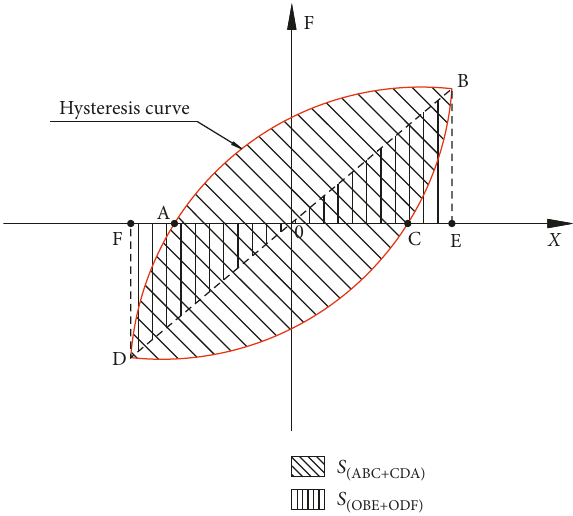
Figure 13: Schematic diagram of the calculation of energy dissi- pation coefficient E